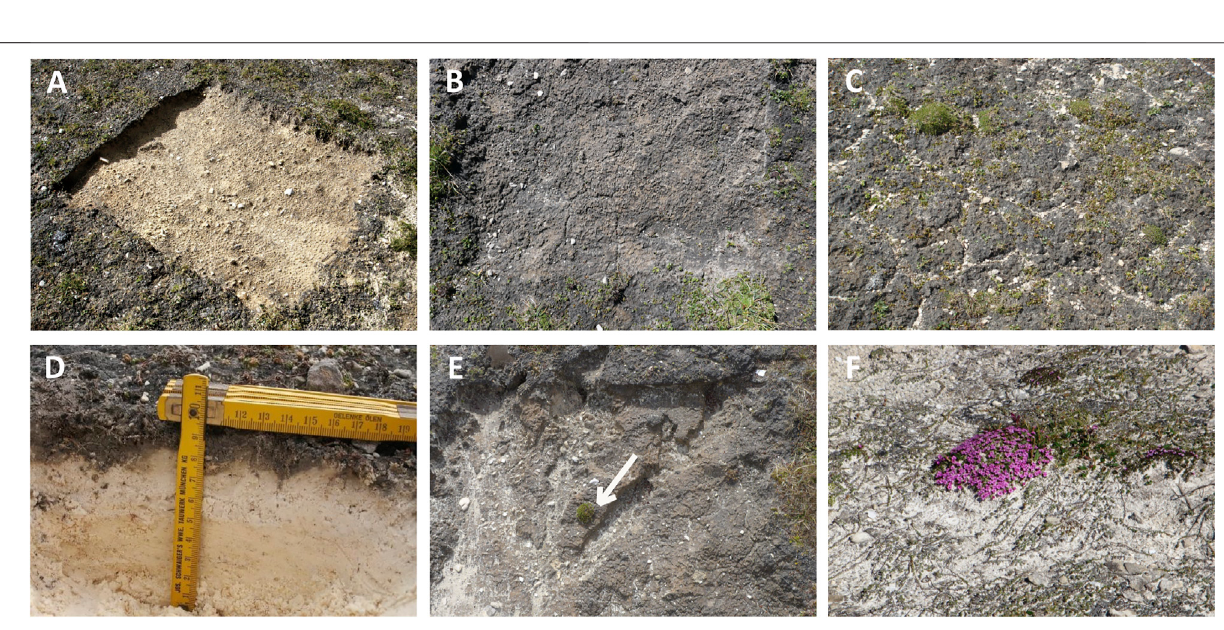
Frontiers in Earth Science |